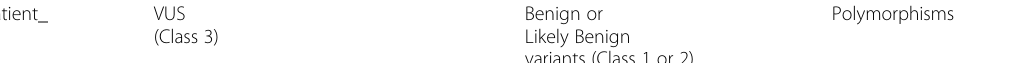
Table 2 Characterization of germline variants found among Norwegian familial CRC individuals